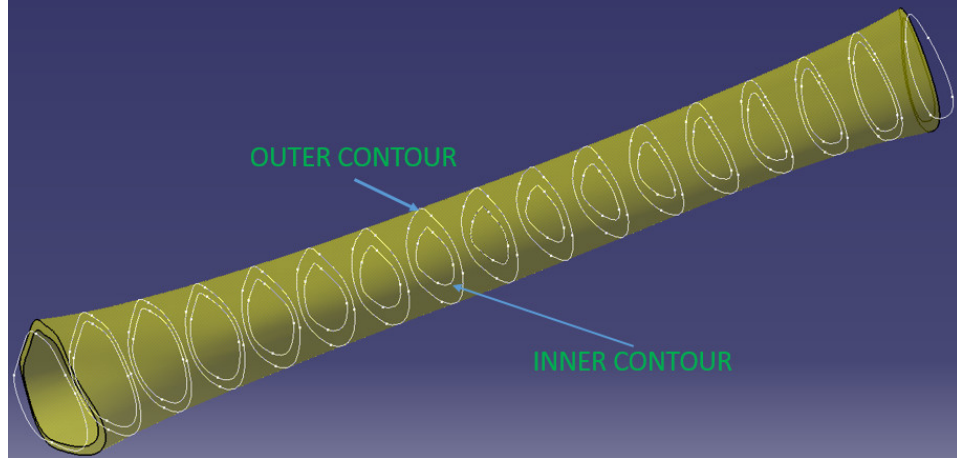
Figure 3. Diaphysis 3D model.